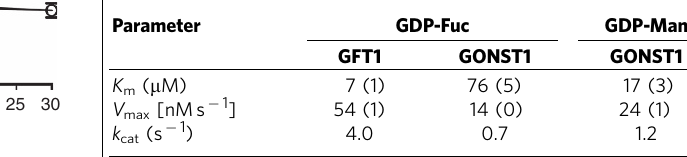
Table 1 | Kinetic parameters of GDP-Fuc and GDP-Man transport into